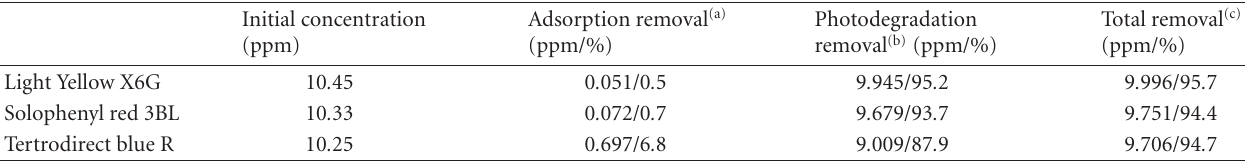
Table 2: Preliminary test and experiments carried out applying optimum parameters. One piece of composite TiO 2 film, two pieces of blue fluorescent lamp, 10 mL of each dye solution with initial pH 6.0 and initial concentration of 10ppm, and temperature (25 ◦ C) with illumination time 300minutes.